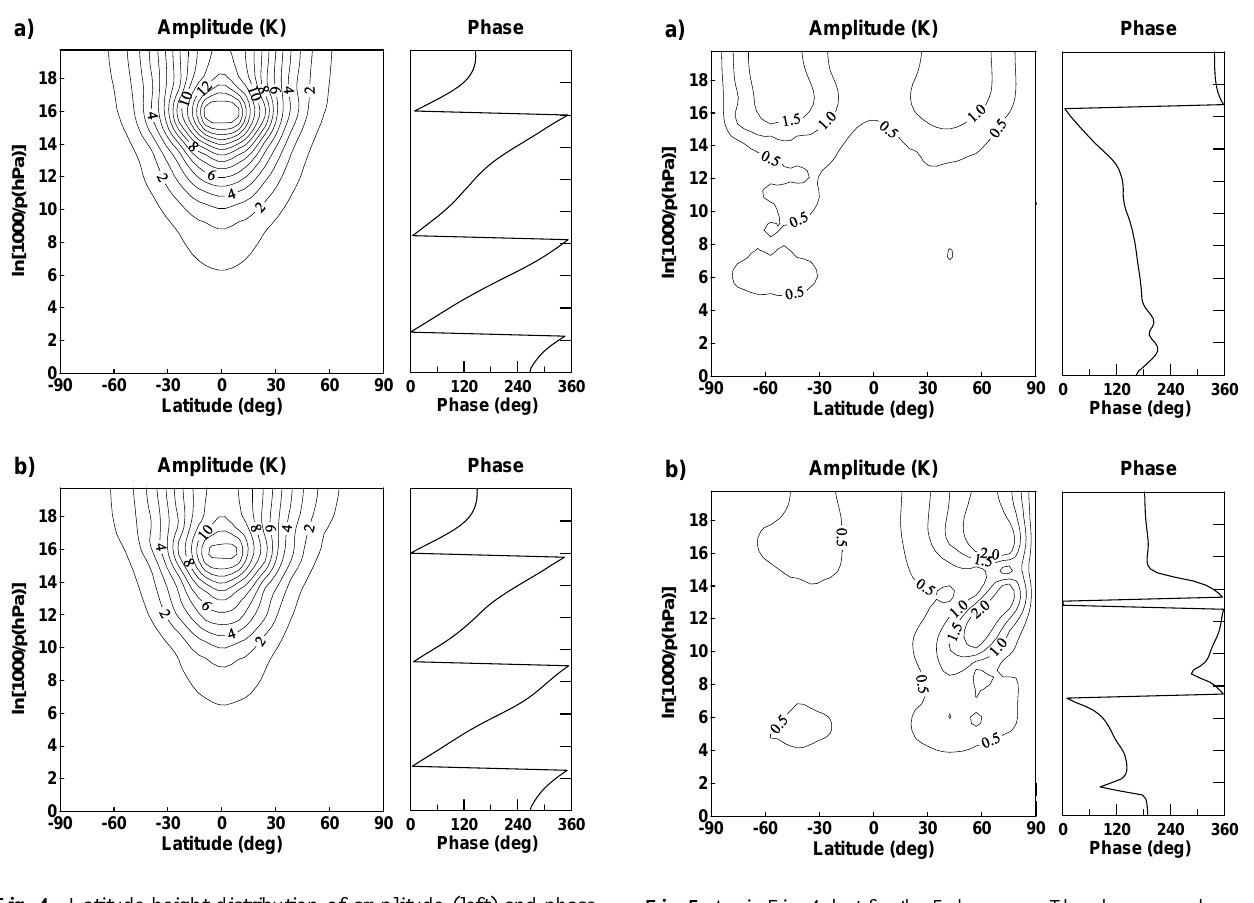
Fig. 5. As in Fig. 4, but for the 5-day wave. The phases are shown at 45 ◦ S ( a ) and 45 ◦ N ( b ) .